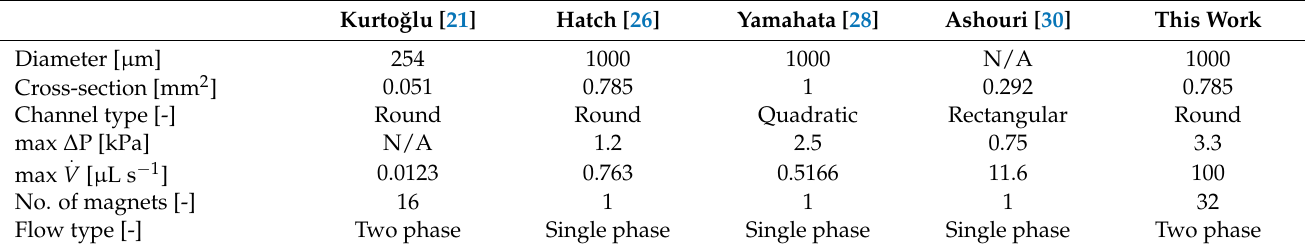
Table 3. Comparison between different pumping concepts